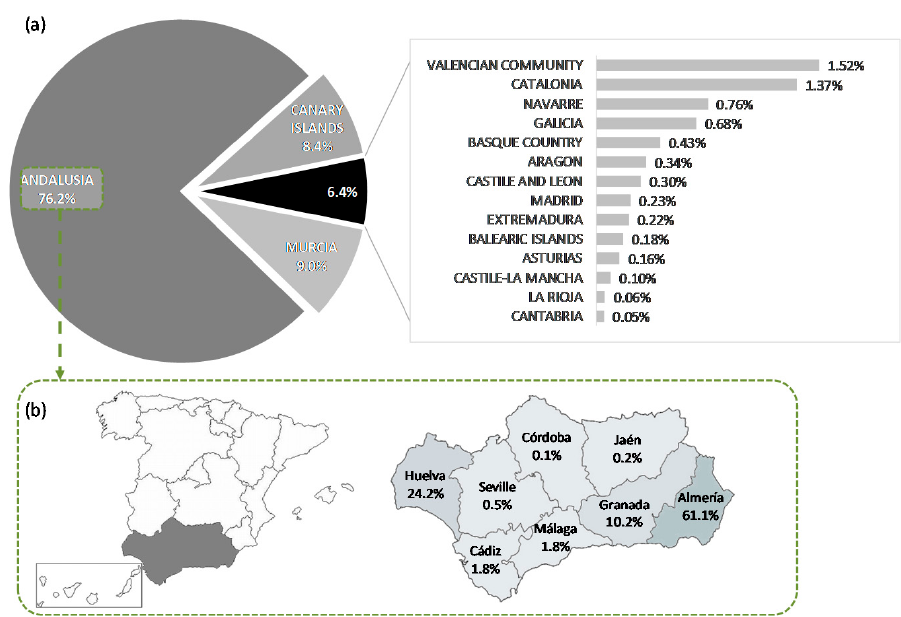
Figure 3. Distribution of the crop area under greenhouse in 2019 for the ( a ) Spanish Autonomous Communities and ( b ) Andalusian provinces [2].